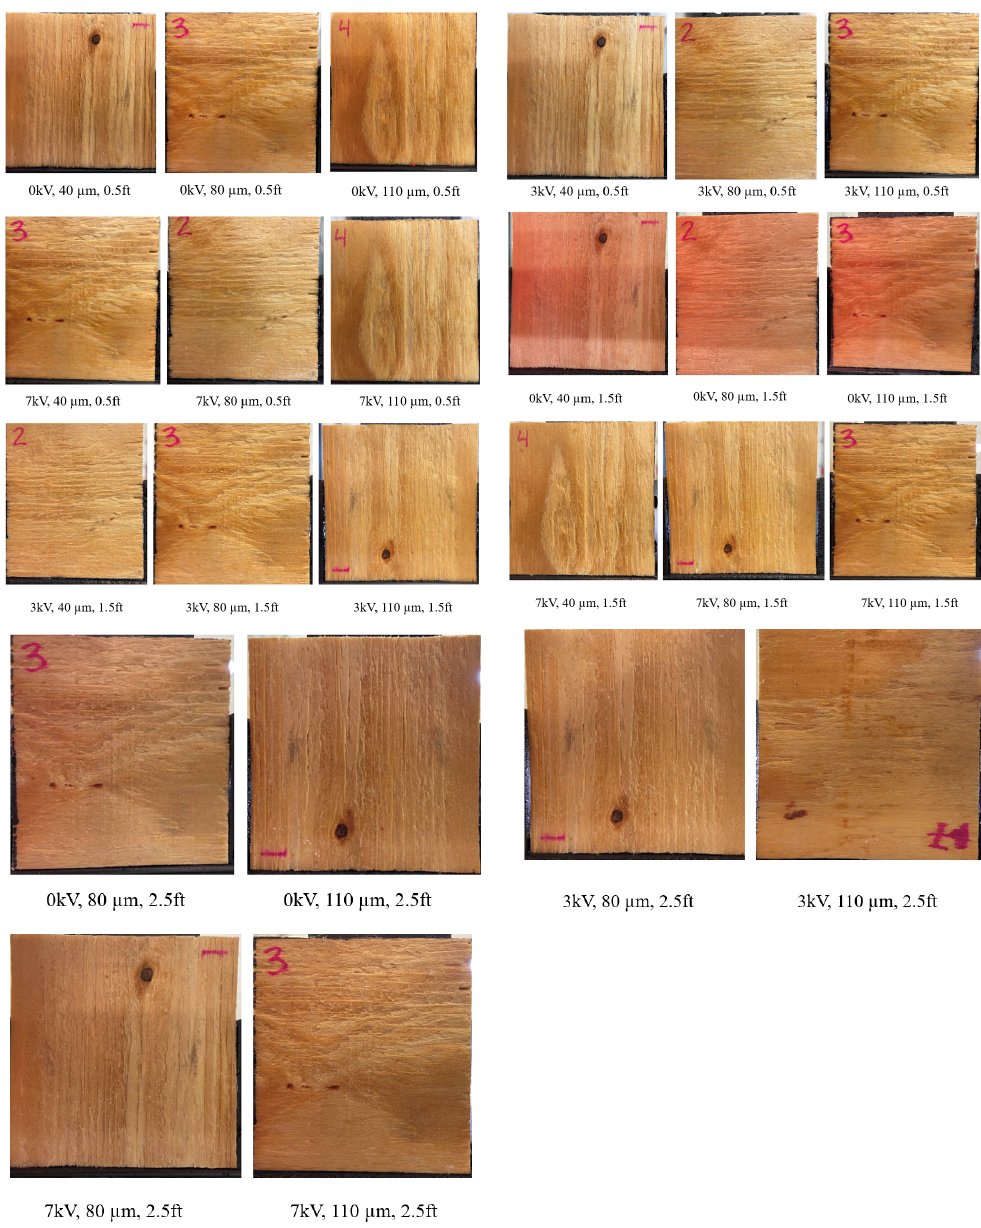
Figure A7. Wood: qualitative images of electrostatic deposition under various system